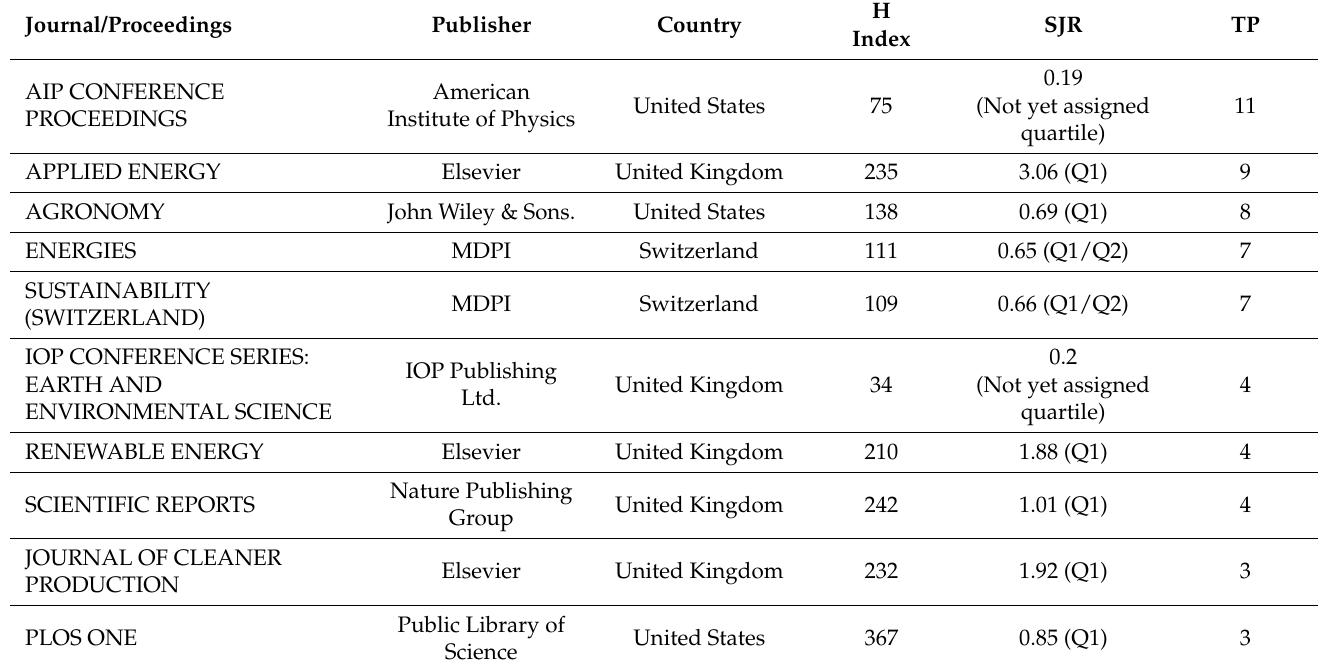
Table 2. Most productive scientific sources.